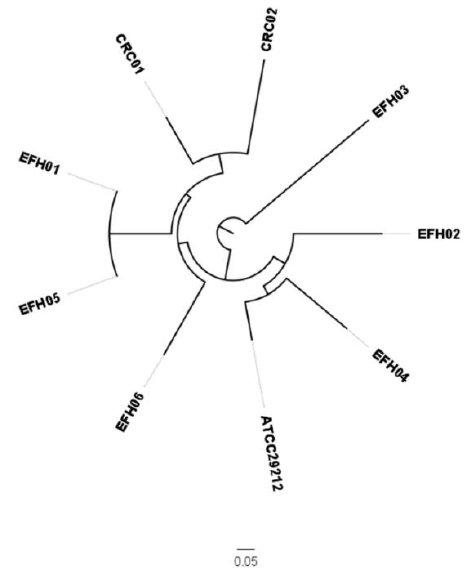
Figure 1. Phylogenetic tree of isolated E. faecalis strains. The phylogenetic tree was generated using the ATCC 29212 genome (GenBank acc. no. NZ_CP008816.1) as a reference. CRC: colorectal cancer; EHF: Enterococcus faecalis healthy.